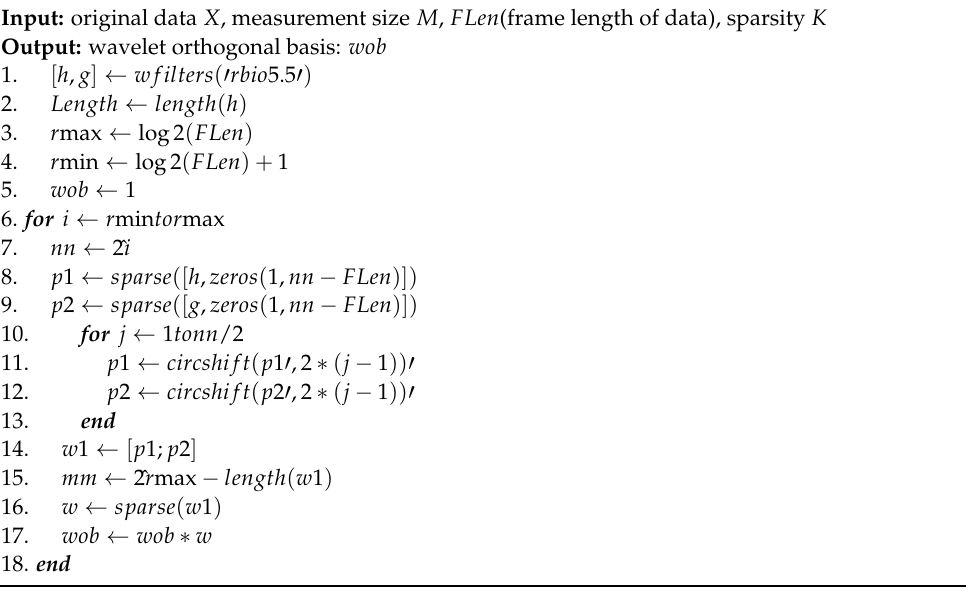
Algorithm 3 orthogonal wavelet basis algorithm